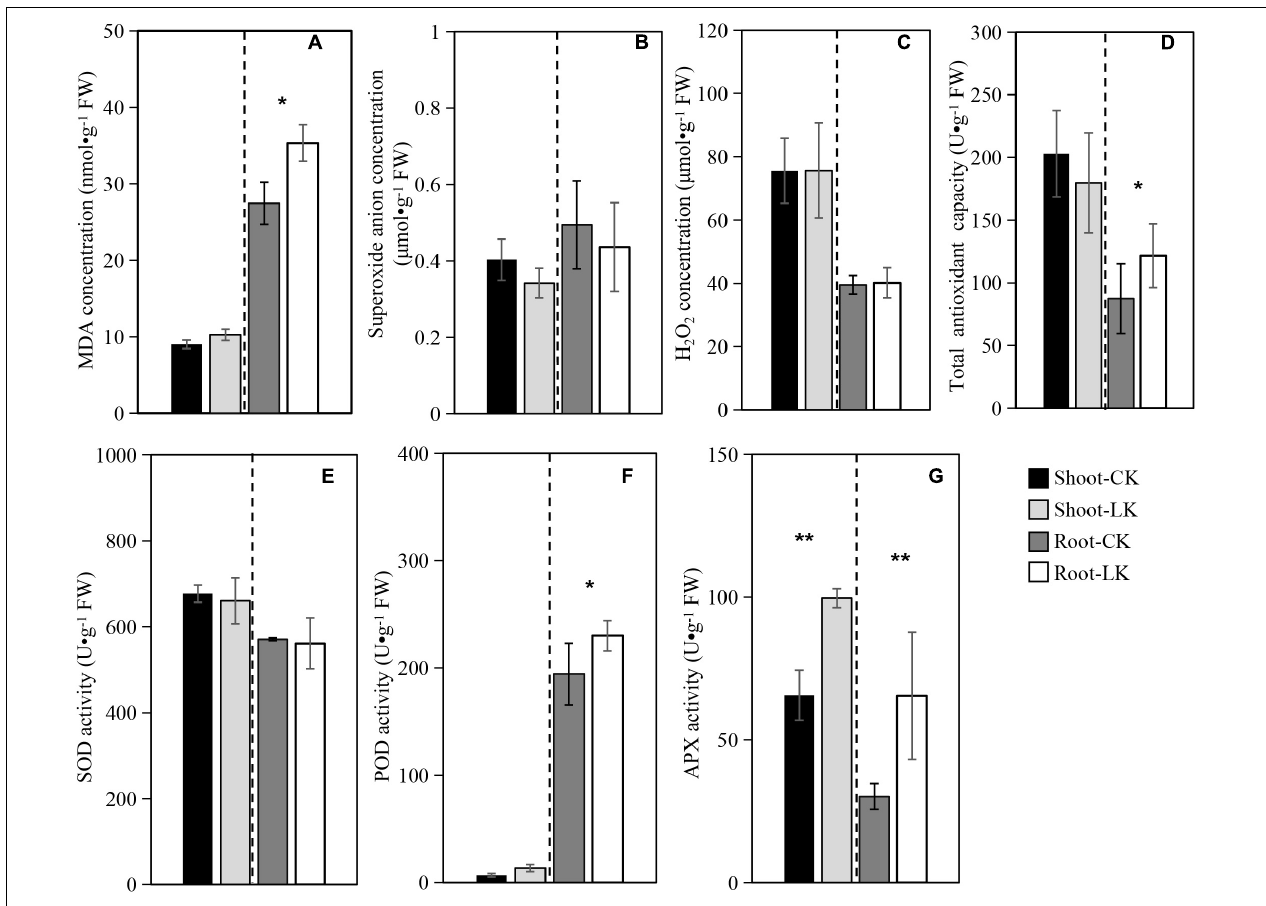
FIGURE 1 | Oxidative stress physiological parameters. (A) Malondialdehyde (MDA); (B) superoxide anion (OFR); (C) hydrogen peroxide (H 2 O 2 ); (D) superoxide dismutase (SOD); (E) peroxidase (POD); (F) ascorbate-peroxidase (APX); (G) total antioxidant capacity (TAC). Shoot-CK: shoot of NC89 in sufficient K + treatment; Root-CK: the root of NC89 in sufficient K + treatment; Shoot-LK: shoot of NC89 in low K + treatment; Root-LK: the root of NC89 in low K +